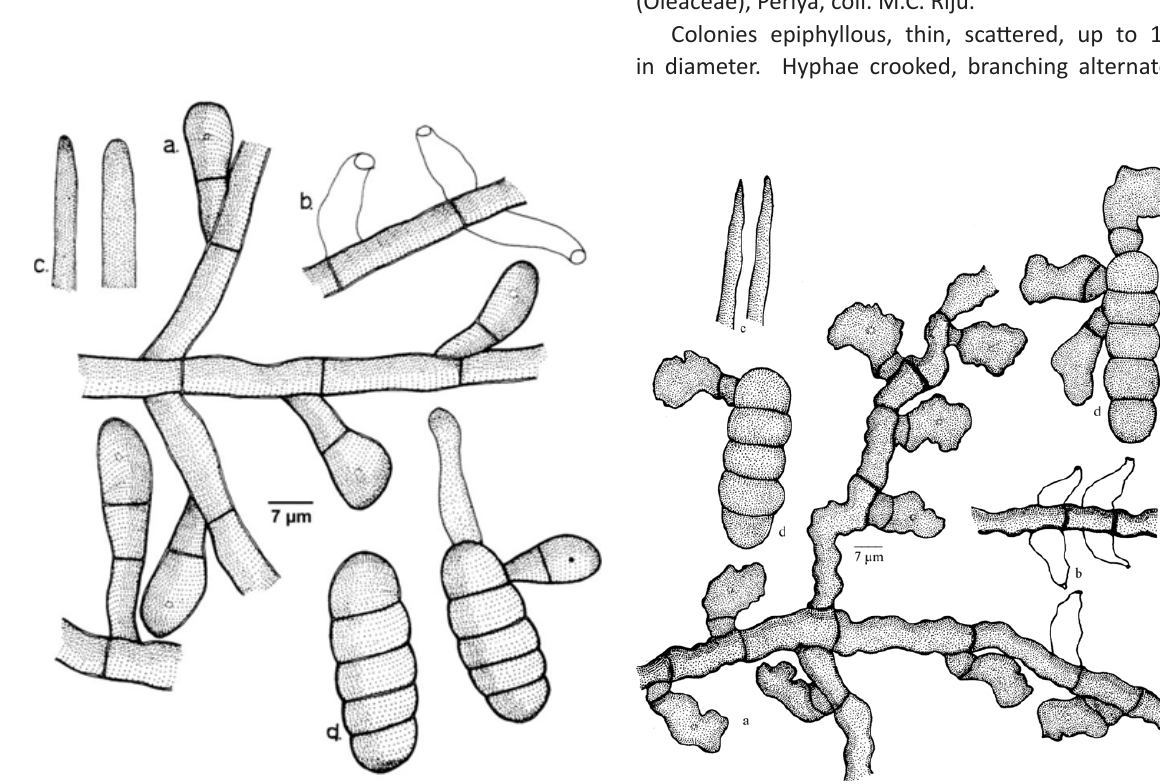
Figure 85. Meliola jasminigena a - Appressorium; b - Phialide; c - Apical portion of mycelial setae; d -